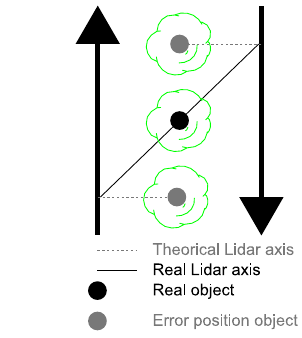
Figure 14. Error produced by misalignment of the LiDAR target axis.